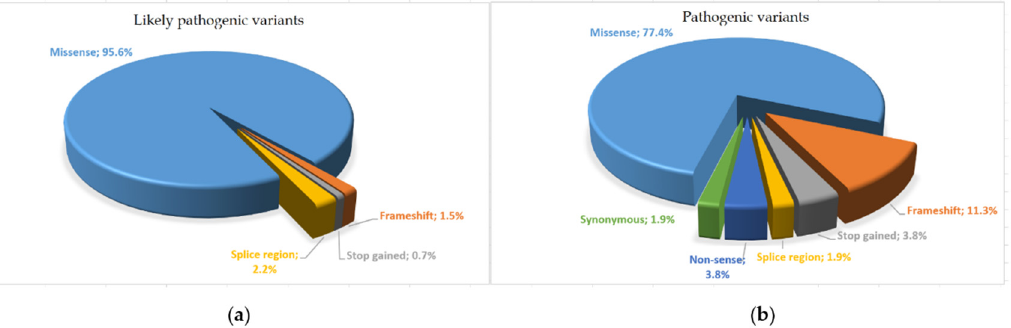
Figure 4. Pie chart of different variant distribution types identified: ( a ) likely pathogenic variants; ( b ) pathogenic variants.